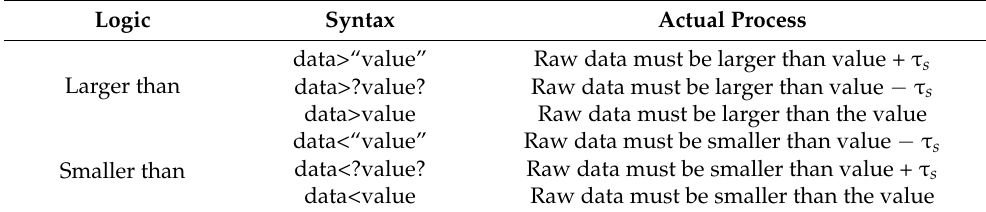
Table 5. The comparison syntax table in different query strategies of an